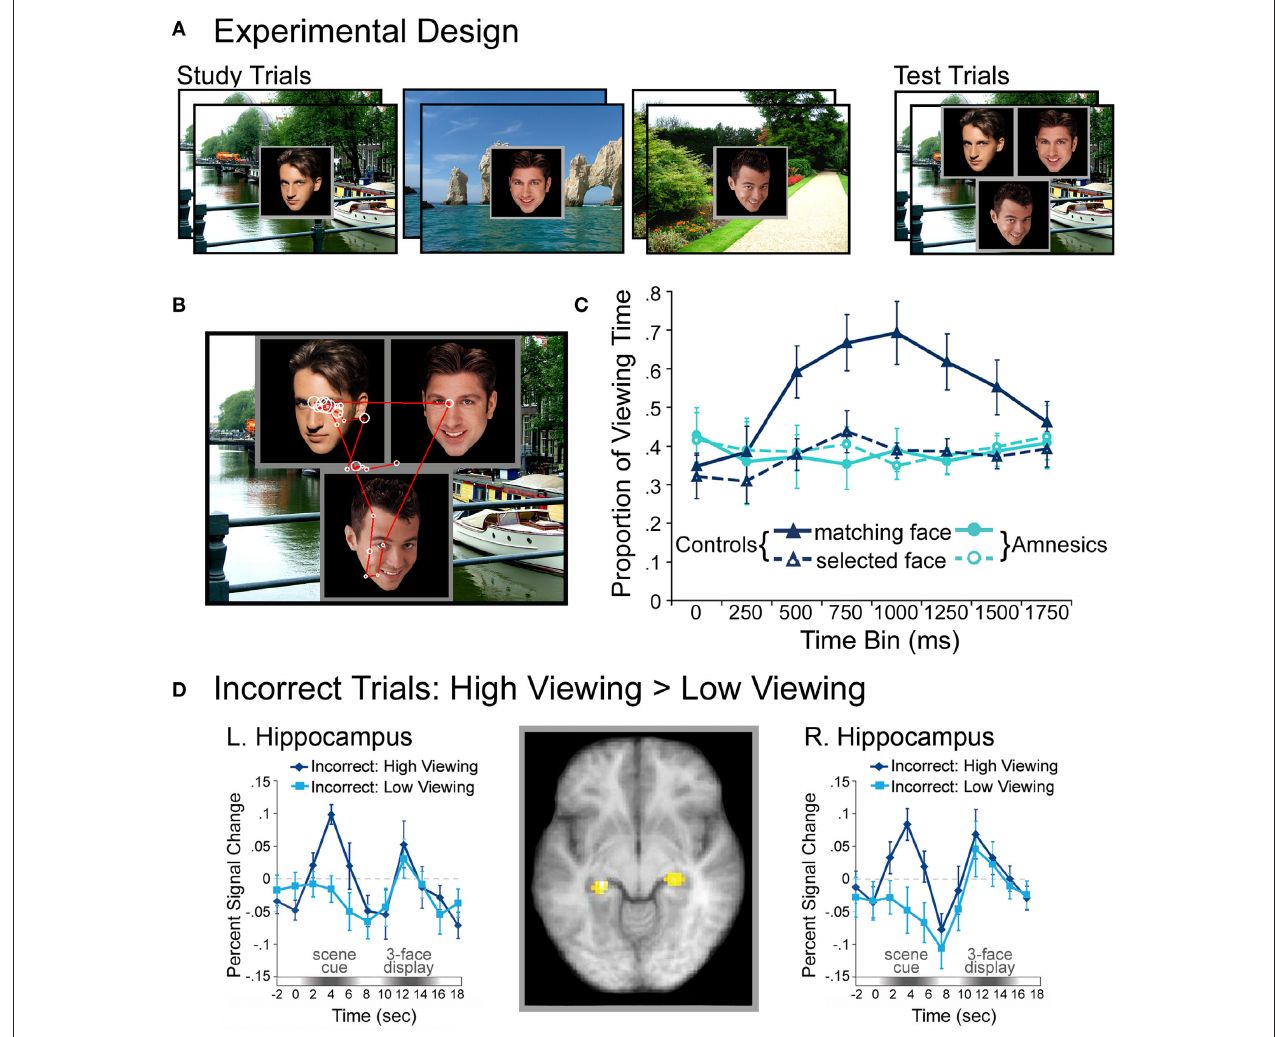
FIGuRE 4 | IIllustration of the basic paradigm and results from Hannula et al. (2007) and Hannula and Ranganath (2009) . (A) Examples of scene-face pairs presented during the study trials, along with a single, associated test display in which the face on the left was the match (i.e., was the associate of the scene). Each test trial began with the presentation of a scene cue meant to prompt retrieval of the associated face. (B) Eye movements from a representative participant superimposed on the test display shown above. Fixations are indicated by white circles and the size of the circle